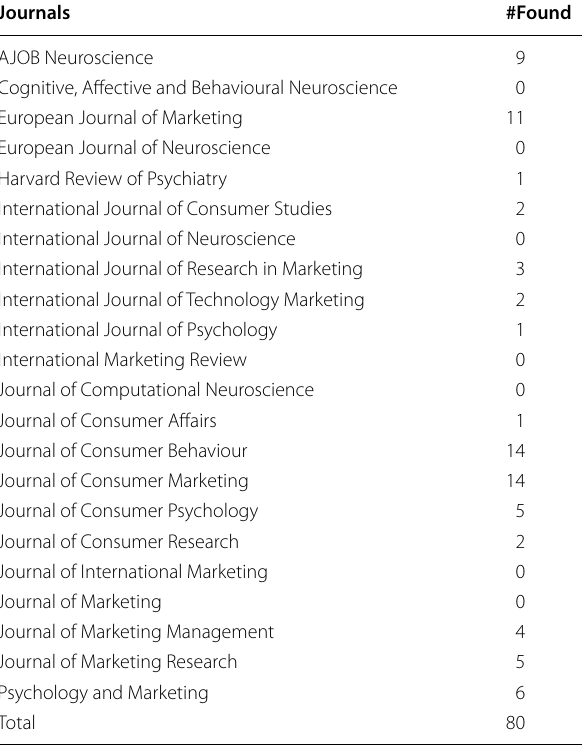
Table 2 A table summarising the journals search for the present systematic review and the number of articles produced by each